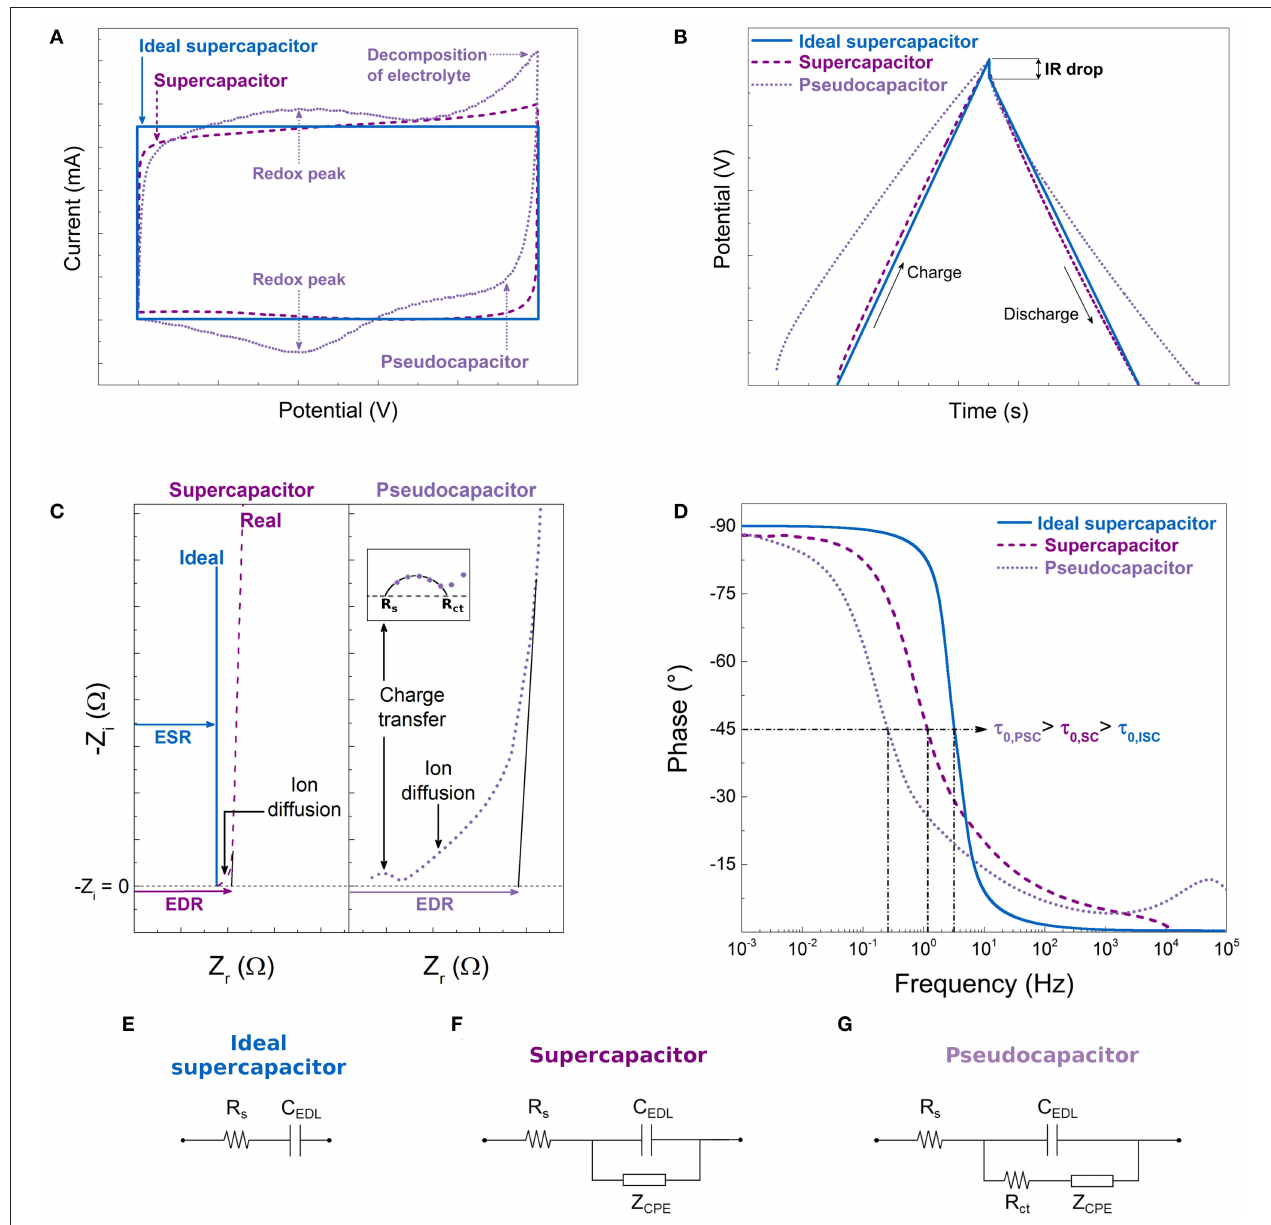
FIGURE 4 | Expected behavior of a supercapacitor (SC) and a pseudocapacitor (PSC) compared to that of an ideal SC during different electrochemical tests: (A) cyclic voltammetry, (B) galvanostatic charge-discharge, and (C,D) electrochemical impedance spectroscopy. Simplified equivalent circuits for: (E) ideal SC, (F) SC, and (G)